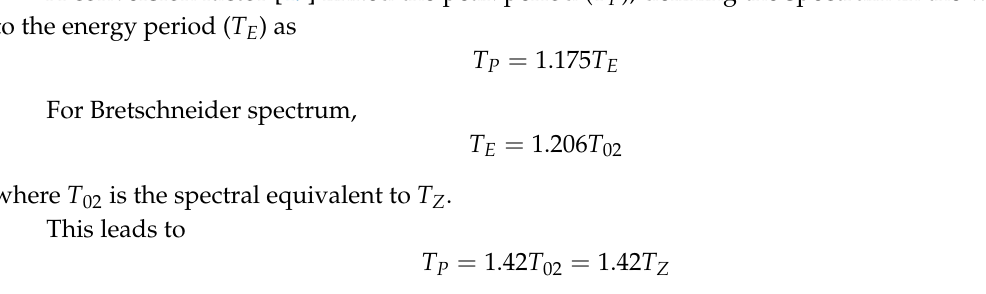
Table 3. Selected wave cases at ocean basin testing model scale.